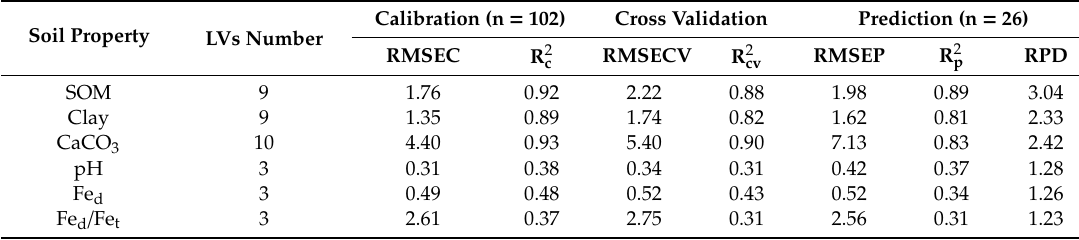
Note: LVs is latent variables, RMSEC is root mean square error for calibration, RMSECV is root mean square error for cross validation, RMSEP is root mean square error for prediction, R (cid:2913)(cid:2870) is coefficient of